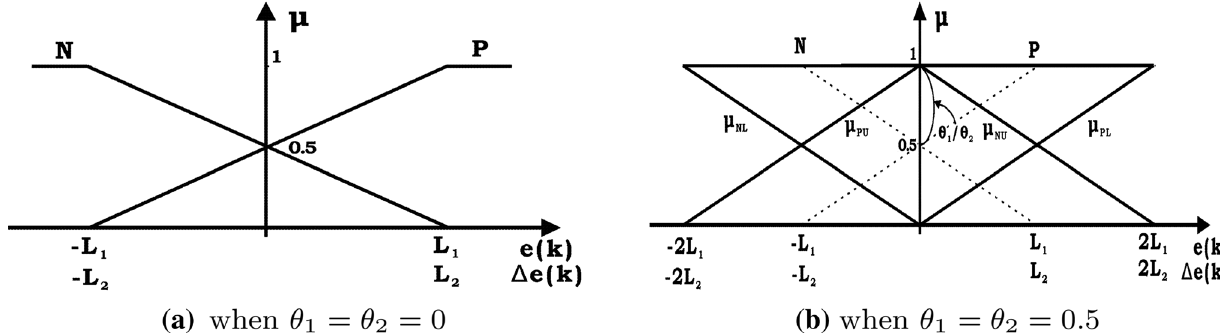
Fig. 3 Membership functions for input fuzzy sets with varying